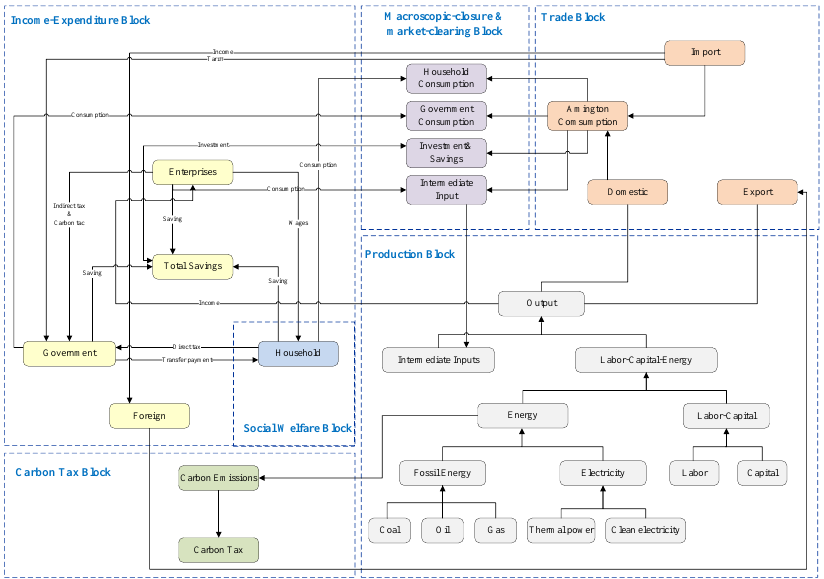
Figure 1. The framework of the CGE model.